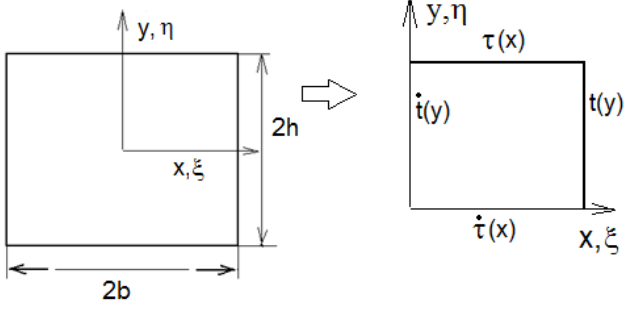
Figure 1. Coordinate system adopted in the analysis.